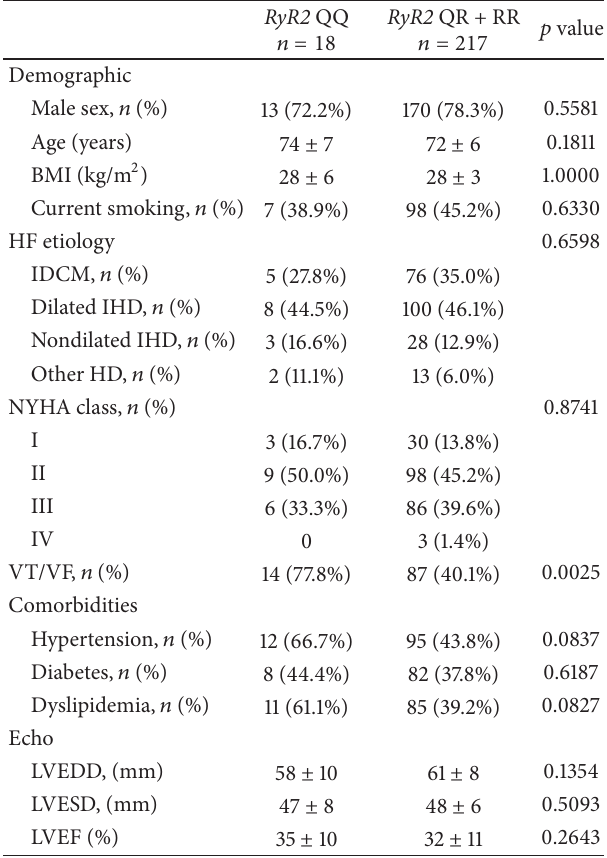
Table 6: Clinical characteristics and events stratified according to RyR2 allele